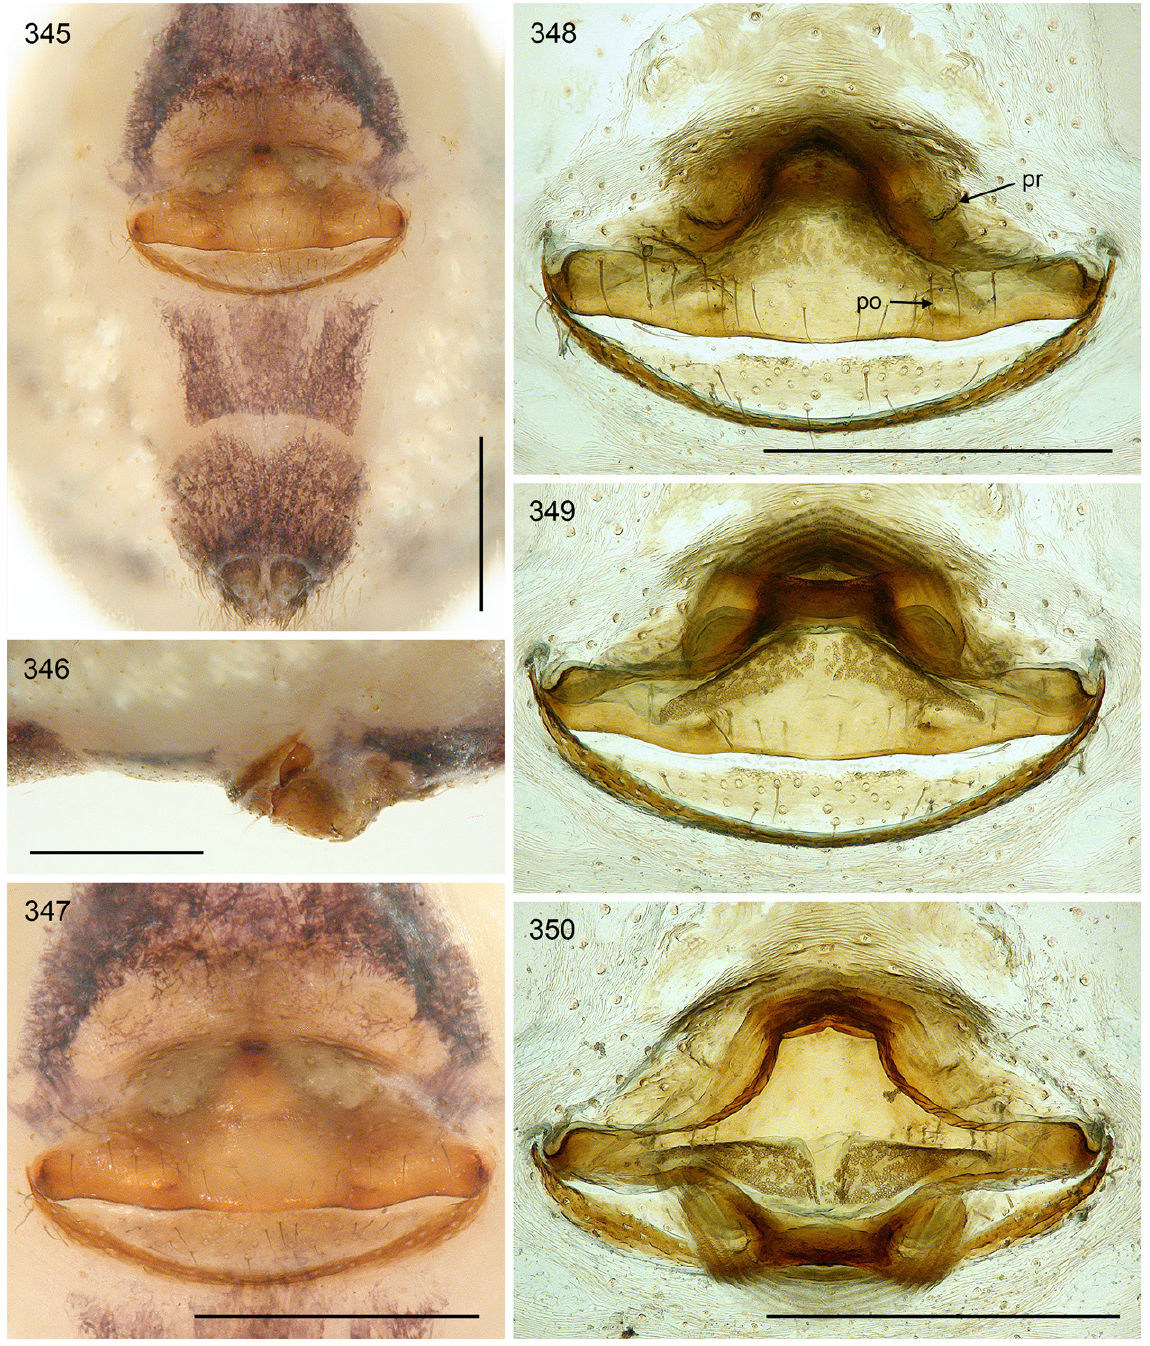
Figs 345–350. Maghreba djabalija gen. et sp. nov.; female from Morocco, NE of Tizi n’Test (ZFMK Ar 22390). 345 . Abdomen, ventral view. 346–347 . Epigynum, lateral and ventral views. 348–350 . Cleared female genitalia, ventral view, regular dorsal view, and dorsal view with dorsal arc tilted backwards. Abbreviations: po = pocket; pr = epigynal process. Scale bars = 0.5